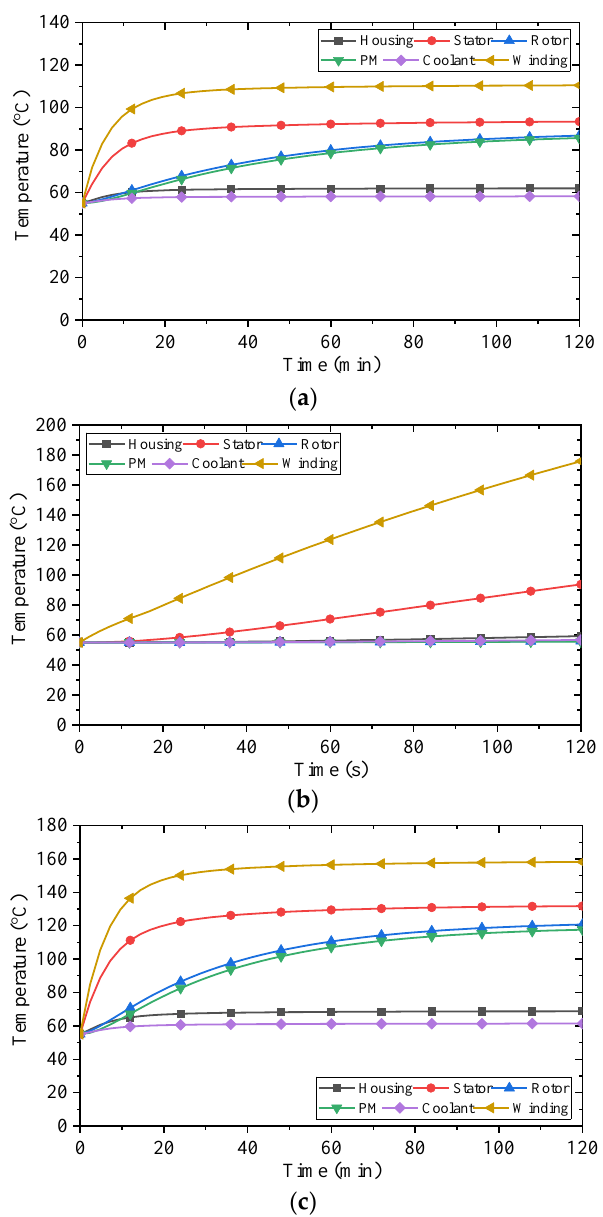
Figure 3. The transient temperature under three typical operating conditions. ( a ) 1500 r/min @ 130 kW. ( b ) 796 r/min @ 200 kW. ( c ) 2700 r/min @ 130 kW.